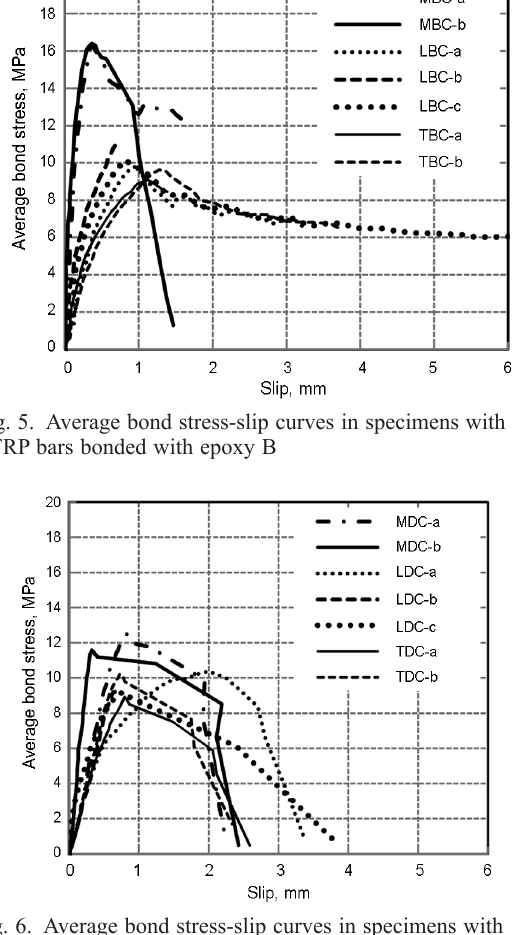
Fig. 6. Average bond stress-slip curves in specimens with CFRP bars bonded with epoxy D